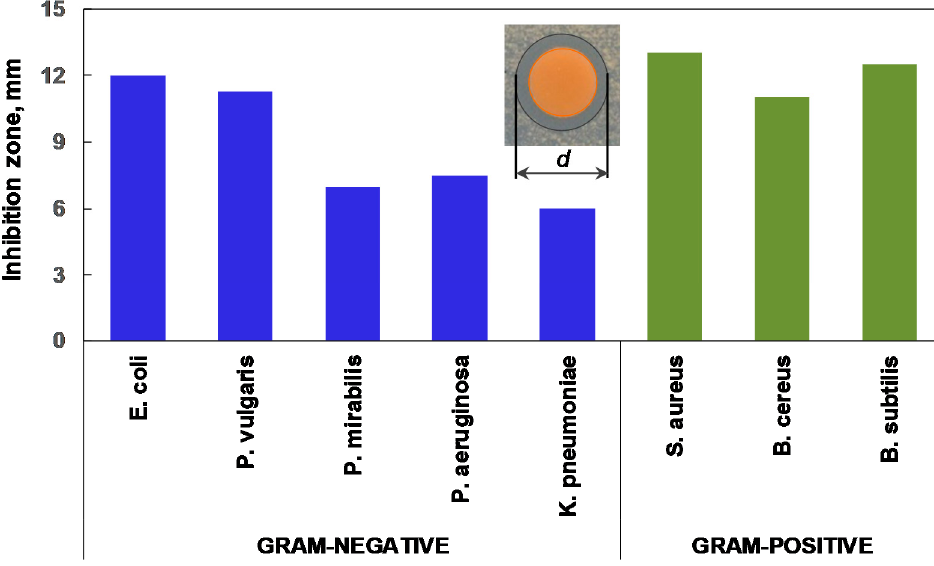
Figure 17. The diameter of the zone of inhibition produced by PDMS/CF–Ag (10 wt.%) composite against Gram-negative and Gram-positive bacteria strains.